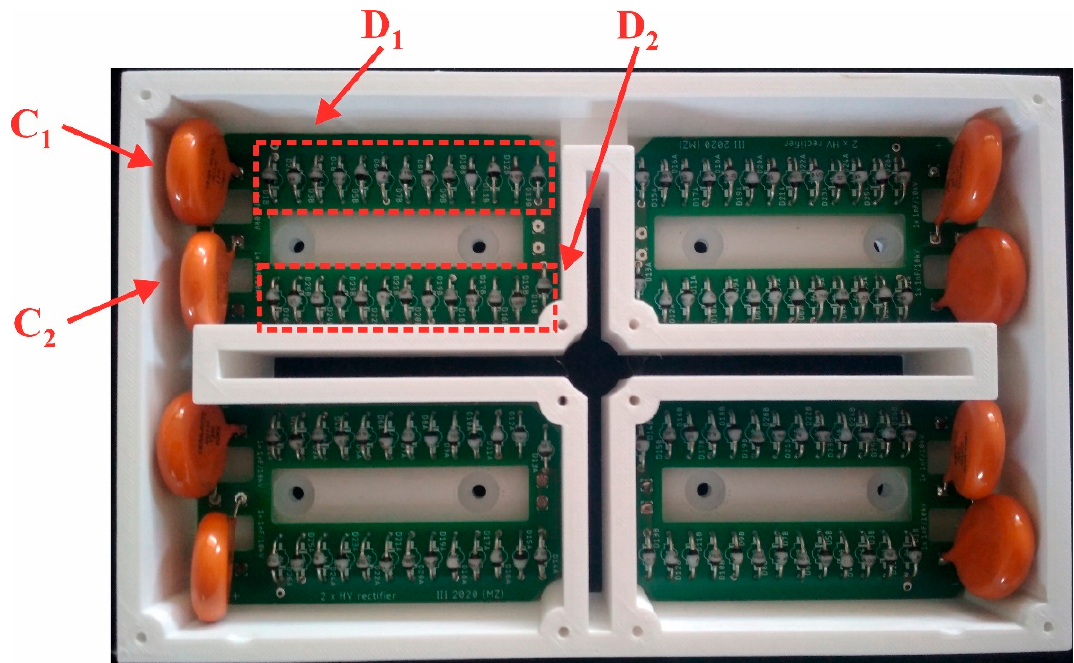
Figure 6. Photo of the high-voltage rectifiers inside housing; markings refer to Figure 5a.